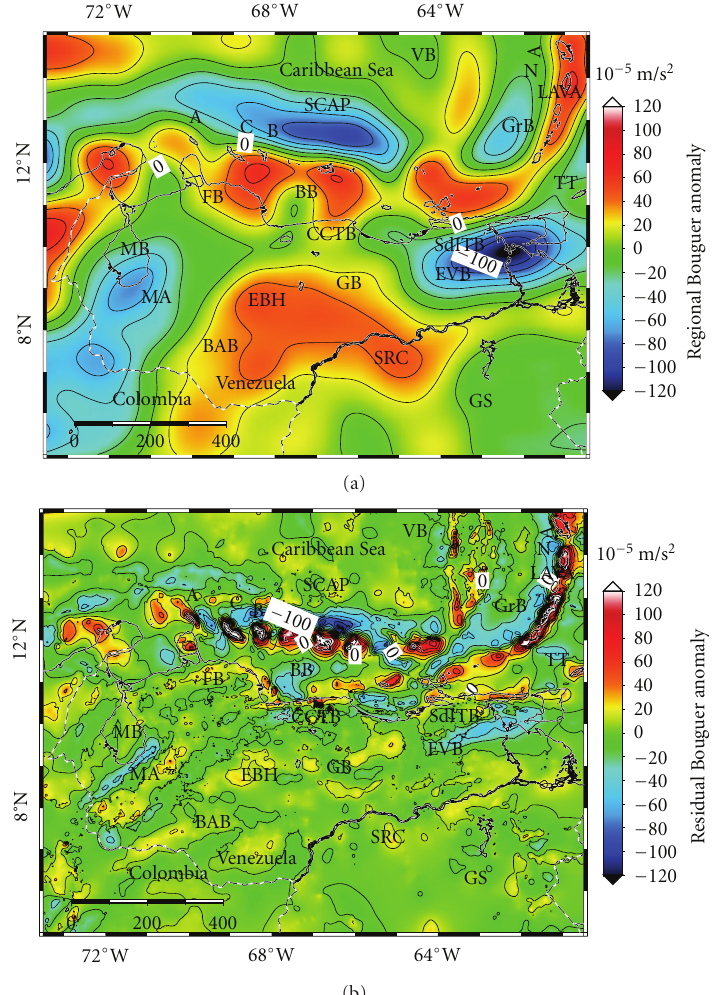
Figure 5: (a) Regional gravity map obtained by applying a Butterworth filter defined by results of the spectral analysis (Figure 4) of the gravity anomaly map. (b) Residual gravity map obtained by subtracting the regional gravity map from the observed gravity map in Figure 3. Both maps: contour interval = 5 × 10 − 5 m/s 2 . Graphical indications as described in Figure